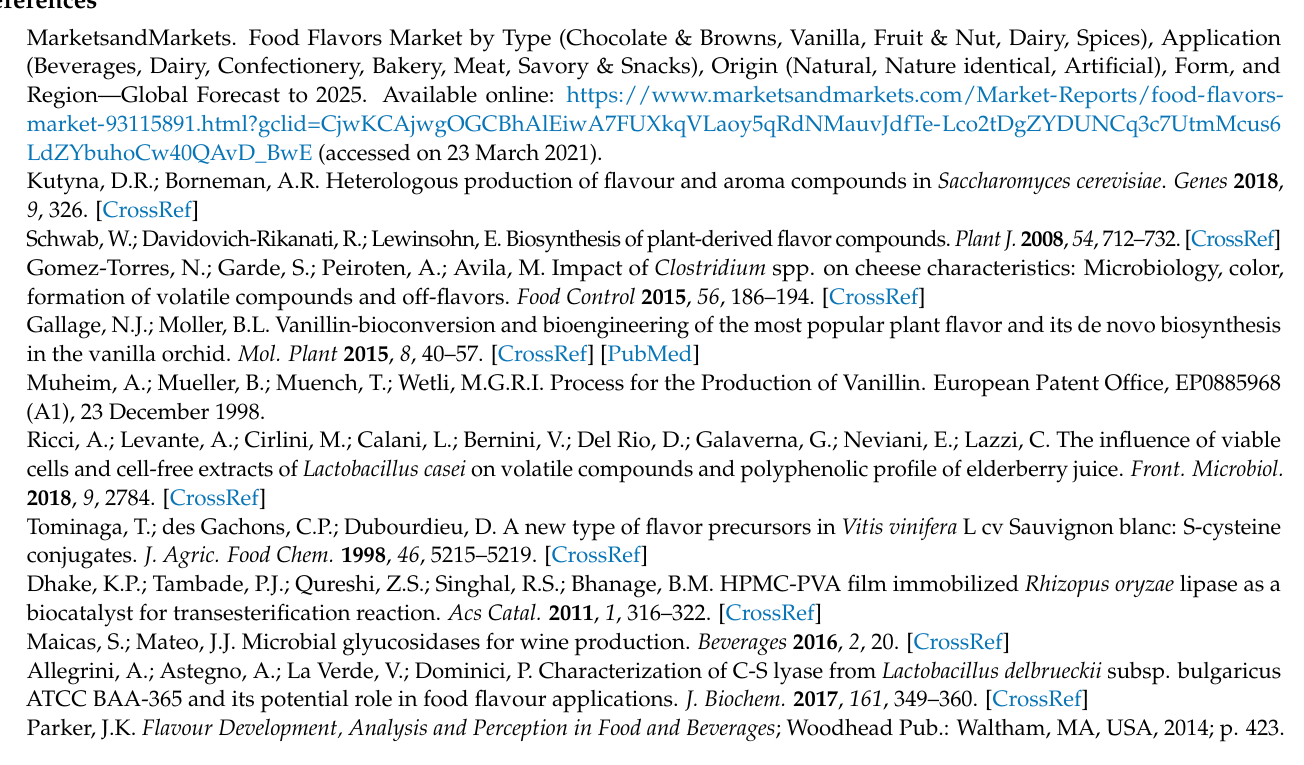
144.0, Table S1: Comparison of different purification methods for cys-4MMP